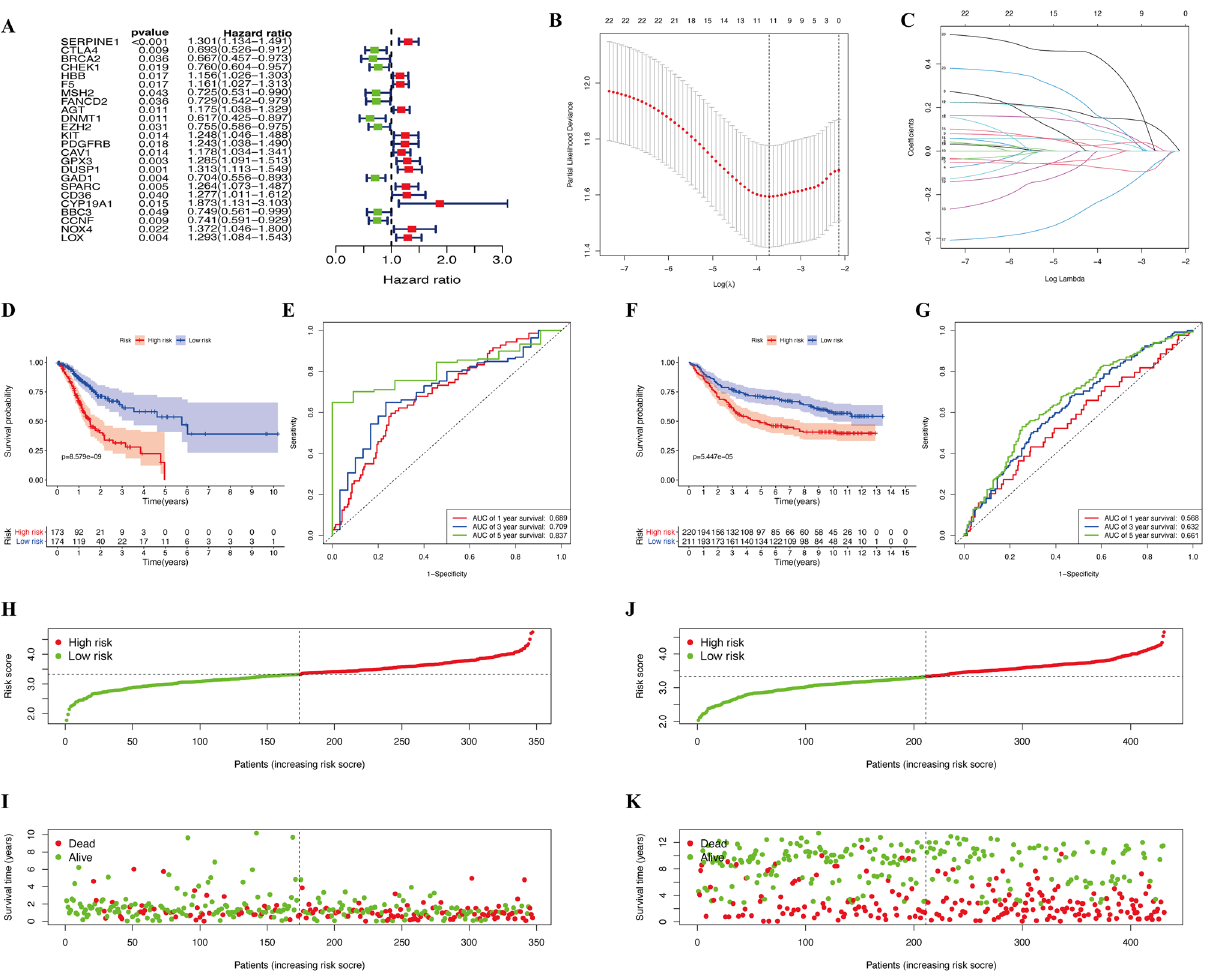
Figure 6. Construction of prognostic model in the TCGA and GSE84437 cohort. ( A ) Univariate Cox regression analysis for identification prognosis-associated OS genes. ( B – C ) LASSO analysis for determining the number of factors and constructing the prognosis prediction model. ( D ) Survival curve of TCGA cohort. ( E ) TimeROC curves for forecasting overall survival in TCGA cohort. ( F ) Survival curve of GSE cohort. ( G ) TimeROC curves for forecasting overall survival in GSE cohort. ( H – I ) Risk score distribution and survival status of TCGA cohort. ( J – K ) Risk score distribution and survival status of GSE